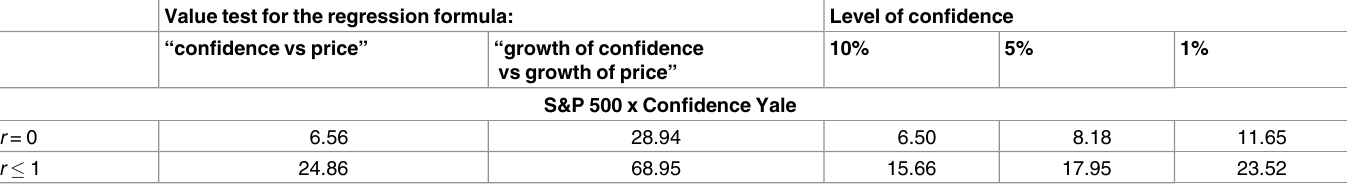
Table 9. Johansen test for confidence x S&P 500. Value test for the regression formula: